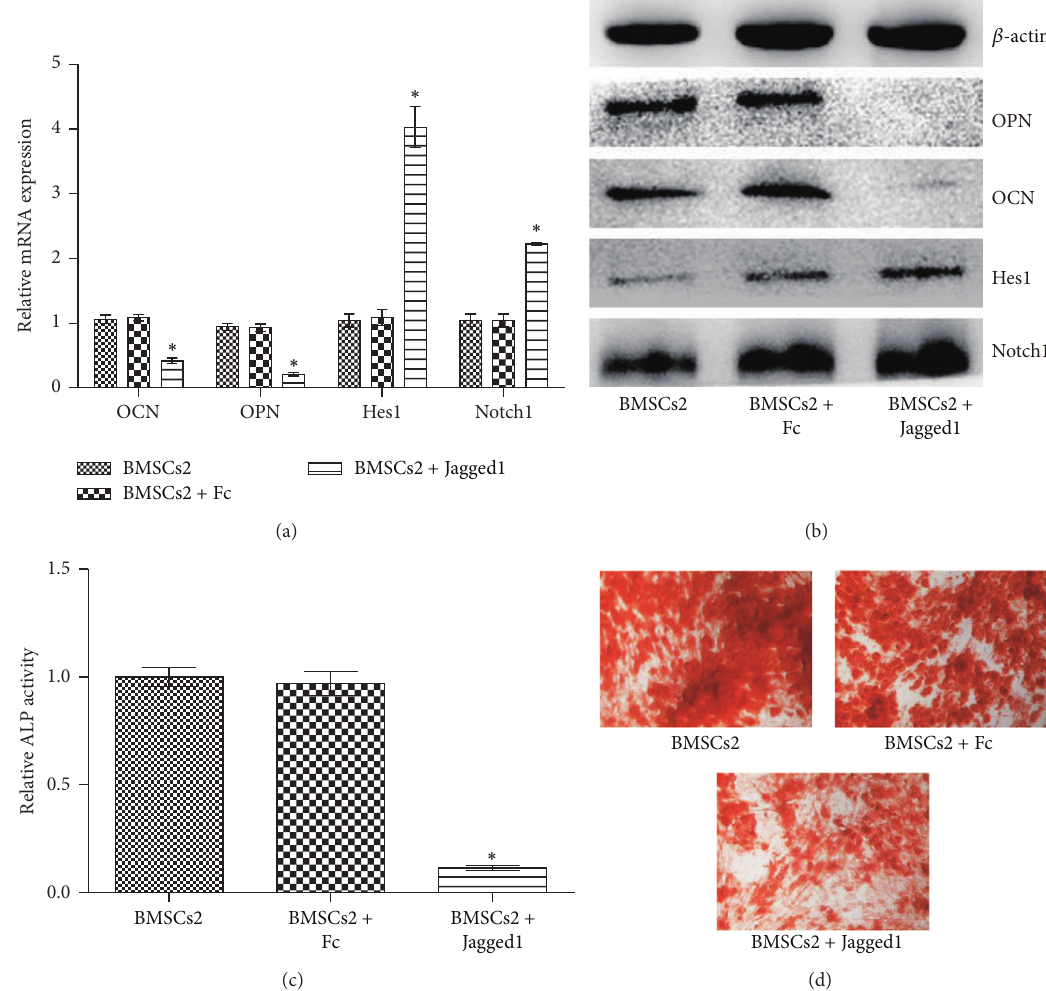
Figure 3: Effect of recombinant protein Jagged1 on osteoblast differentiation of BMSCs. We cultured BMSCs on immobilized soluble Jagged1 ligand in osteogenic induction medium for 3 days or 14 days, with Ig G-Fc as the control. (a-b) The mRNA and protein expression levels of osteogenic differentiation markers OPN and OCN, and Notch1 and Hes1 were analyzed using real-time RT-PCR and western blot analysis after 3-day ( ∗ 𝑃 < 0.05 versus BMSCs2 cultured alone). (c) ALP levels were detected using an ALP kit ( ∗ 𝑃 < 0.05 versus BMSCs2 cultured alone). (d) Calcium deposits were detected using von Kossa